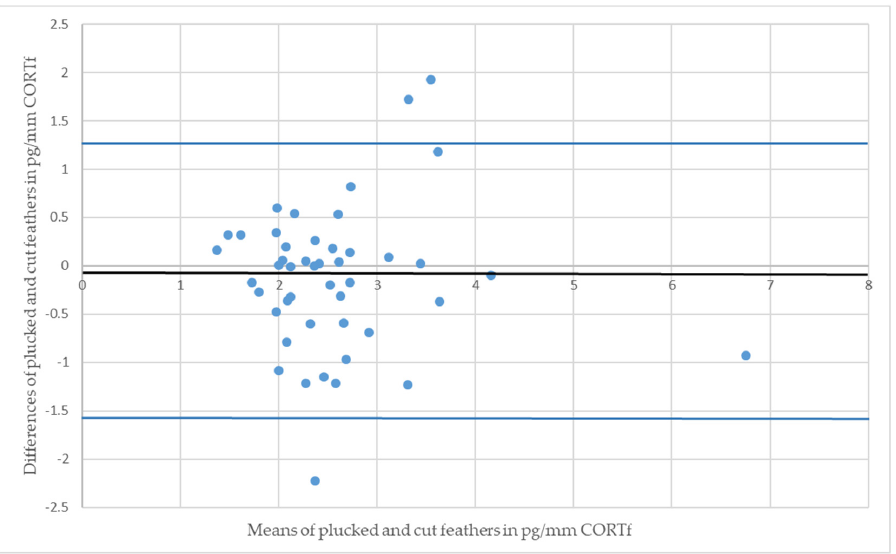
Figure 3. Bland-Altman plot of Mallards ( Anas platyrhynchos ); the residual plot displays the differences ( y -axis) against the means of values ( x -axis) of CORTf in the two sampling methods. The blue horizontal lines represent the mean difference ± 2 SD (mean = − 0.16, SD = 0.65).